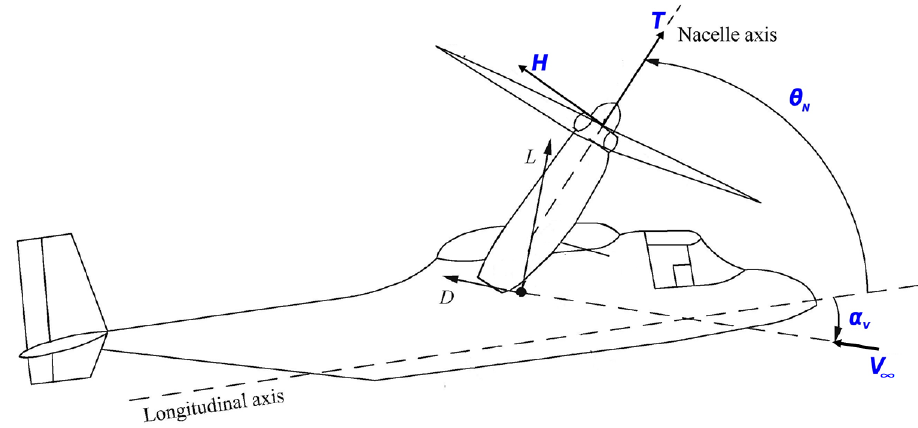
Figure 5. Definition of the main parameters of the full XV-15 tiltrotor configuration.